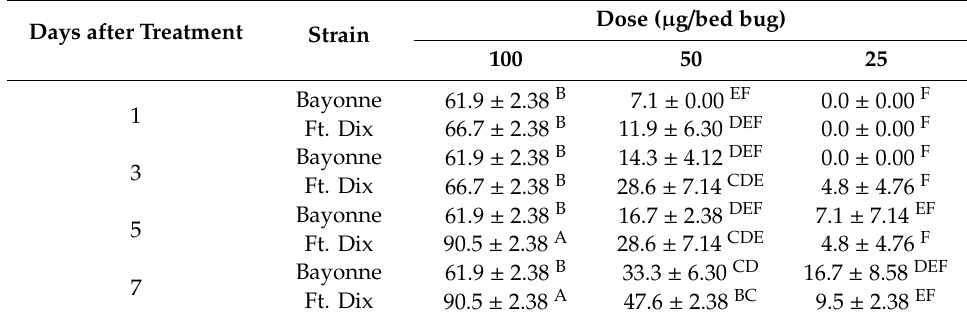
Table 1. Mean ( ± SE) mortality produced by essential oil of Kadsura coccinea “EOKC”, applied topically on two strains of bed